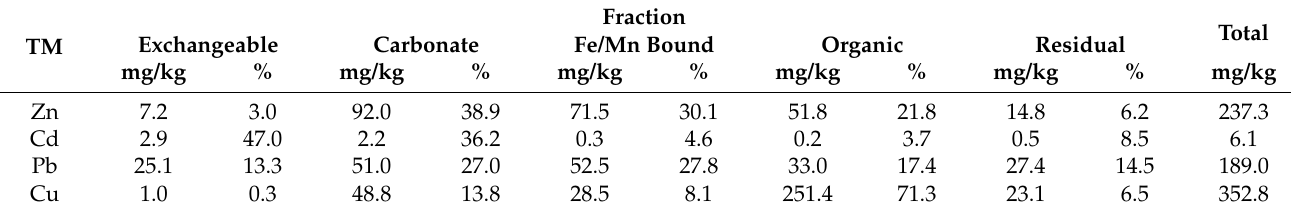
Table 2. TM content, Tessier speciation, raw sediments